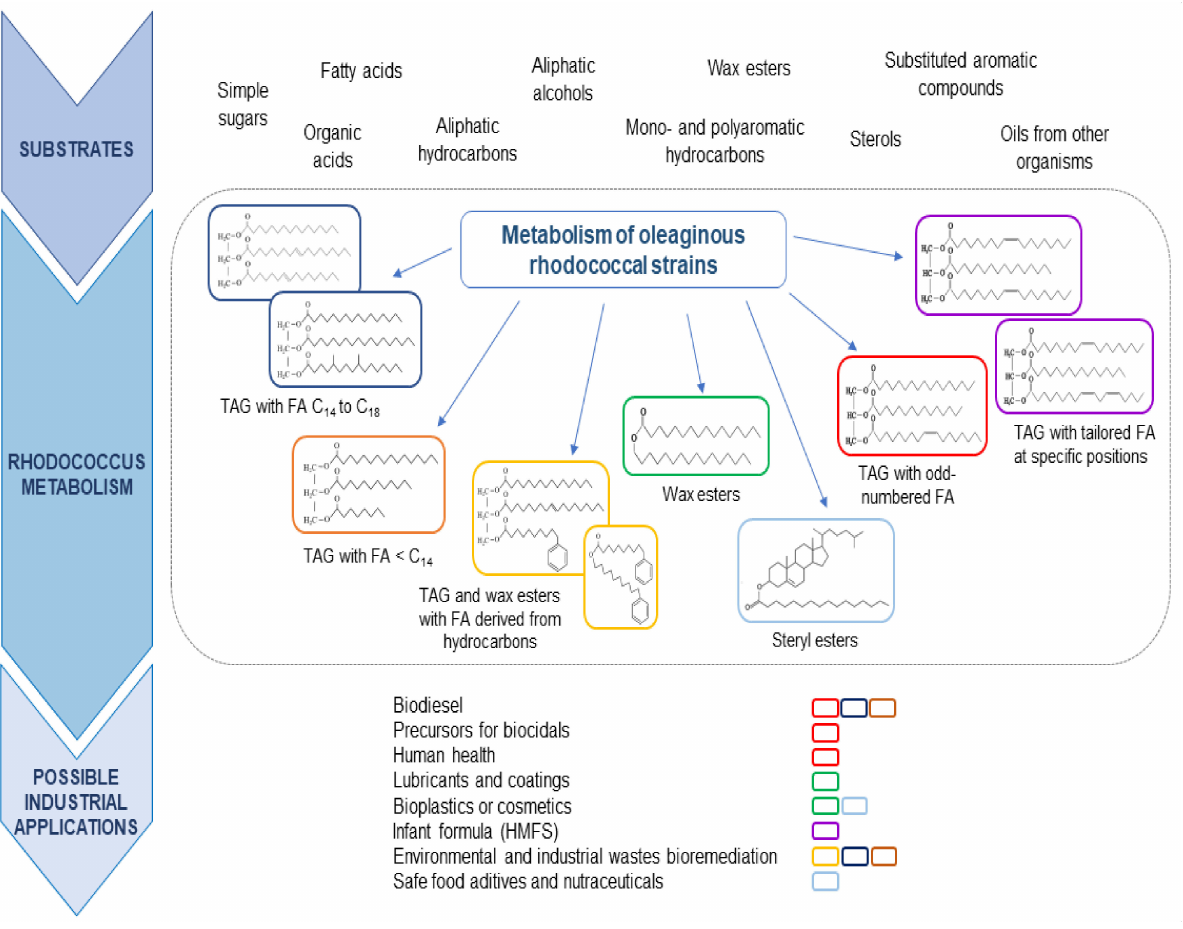
Figure 2. Biotransformation of multiple carbon and energy sources by oleaginous Rhodococcus strains to industrially relevant